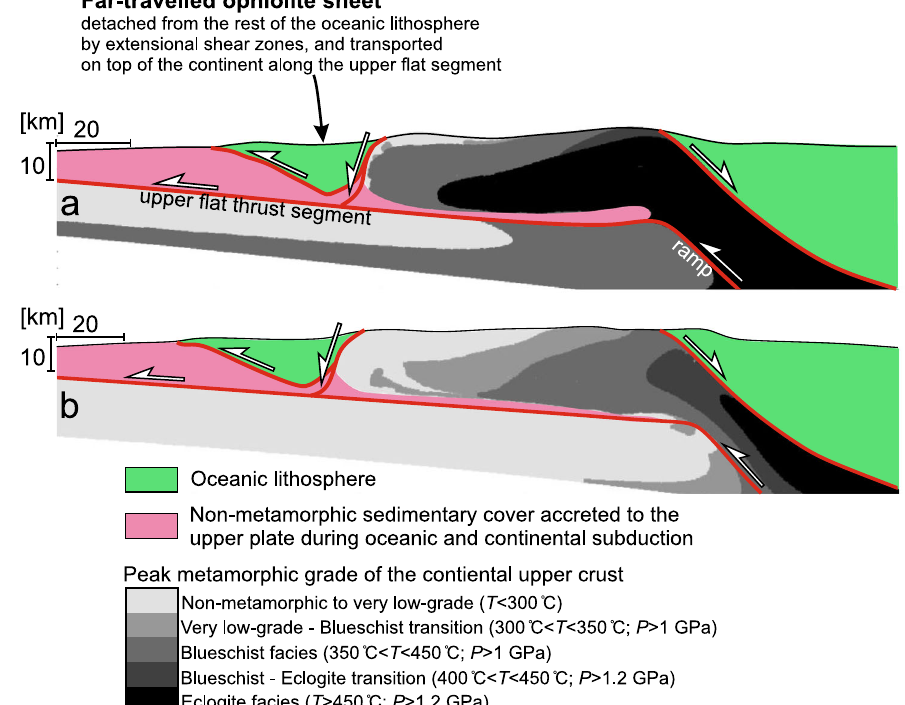
Fig. 6 Near-surface composition and structure of fi nal model snapshots. The peak metamorphic zonation of the exhumed continental upper crust is plotted for a the reference model and b the Mod 1 model variant (for model parameters see Table 2, for initial strength pro fi le see Supplementary Fig. 3). The panels are a combination of calculated metamorphic domains for the continental upper crust, compositional domains for the sedimentary cover and the oceanic lithosphere, and line interpretations of the main shear zones. The peak metamorphic zones are de fi ned based on the recorded maximum pressure (P) and temperature (T) values of the upper crustal particles throughout the entire model evolution, and hence represent the theoretical maximum metamorphic grade reached by the given crustal domains. In both cases, a transition from non-metamorphic to eclogite-grade metamorphic rocks are observed within the upper crustal tectonic window. The reference model (Fig. 6a) has a higher initial continental geothermal gradient (TMOHO = 510 °C), therefore it shows higher peak metamorphic grades compared to the model (Mod 1) with colder Moho temperature (TMOHO = 375°C; Fig.